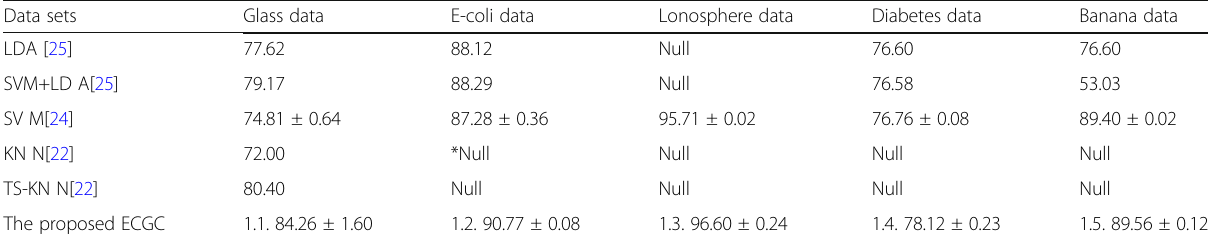
Table 4 Description of five selected machine learning data Data sets